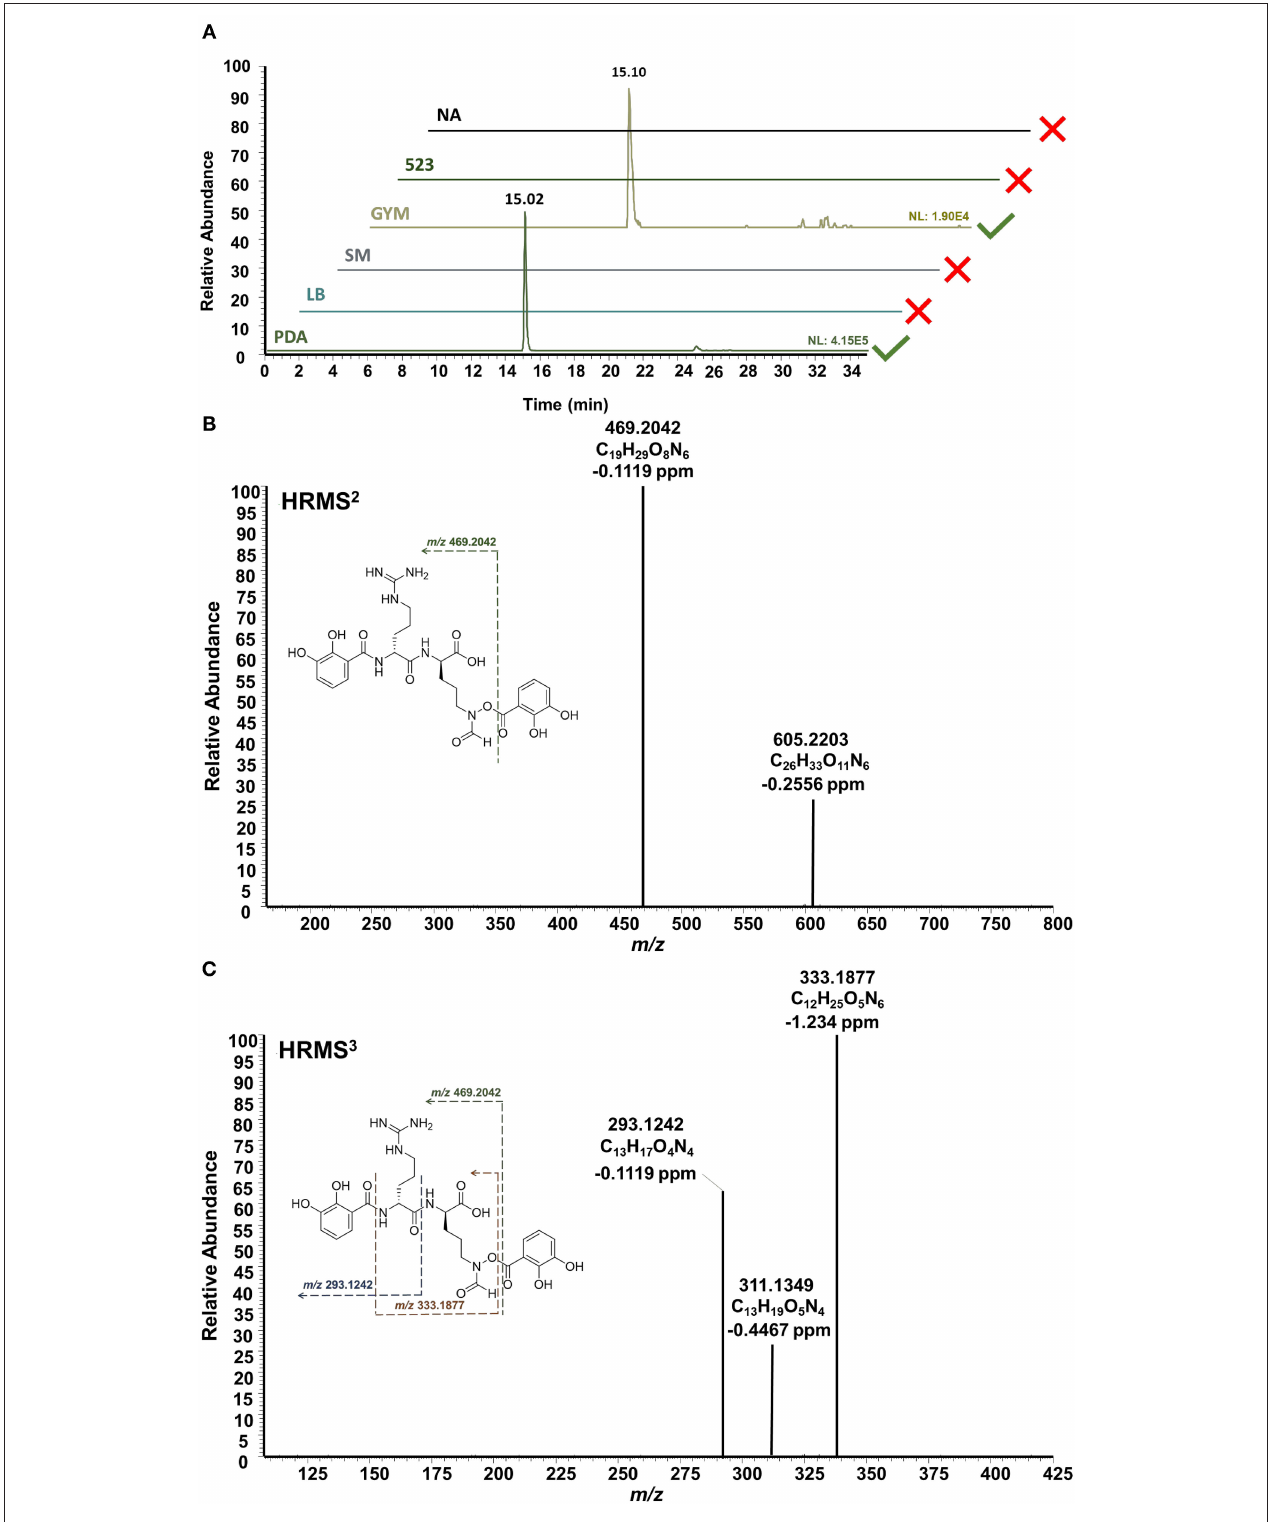
FIGURE 5 | HPLC-HRMS n analysis of mirubactin ( 8 ). (A) Extracted ion chromatograms ([M + H] + , m/z 605.2192, ± 2 ppm] shows the selective production of mirubactin ( 8 ) only on GYM agar and on PDA. (B) HRMS 2 of mirubactin ( 8 ). (C) HRMS 3 of mirubactin ( 8 ). The proposed mass spectral fragmentation pathway is annotated on the compound